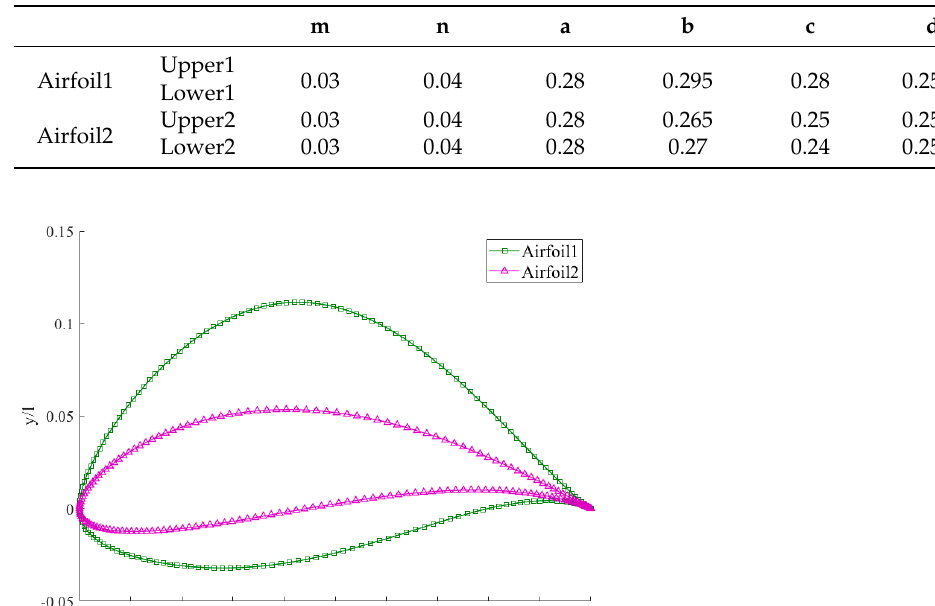
Figure 11. Pressure distribution. ( a ) AoA = 3°; ( b ) AoA = 8°.